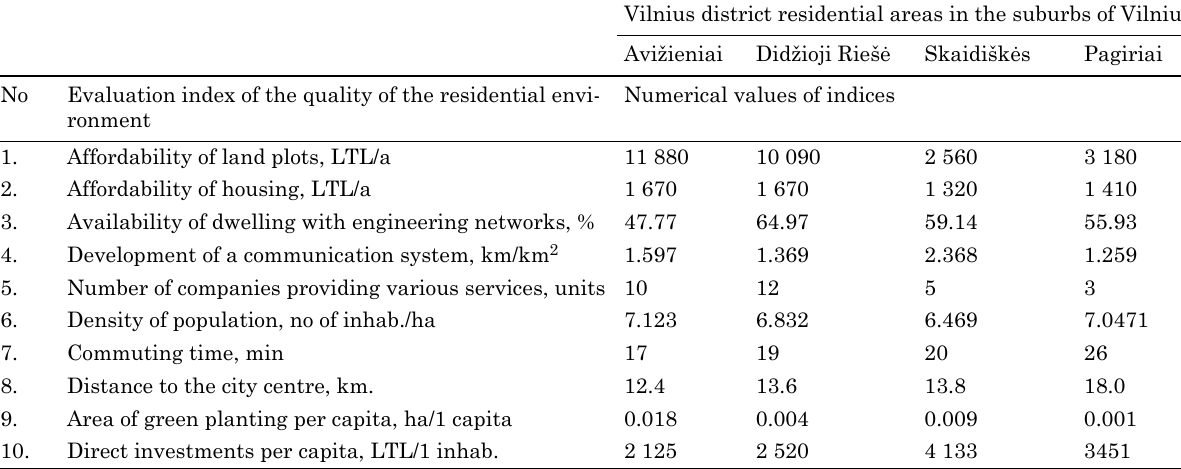
Table 2. Indices of the quality of the residential environment in suburban areas of Vilnius in